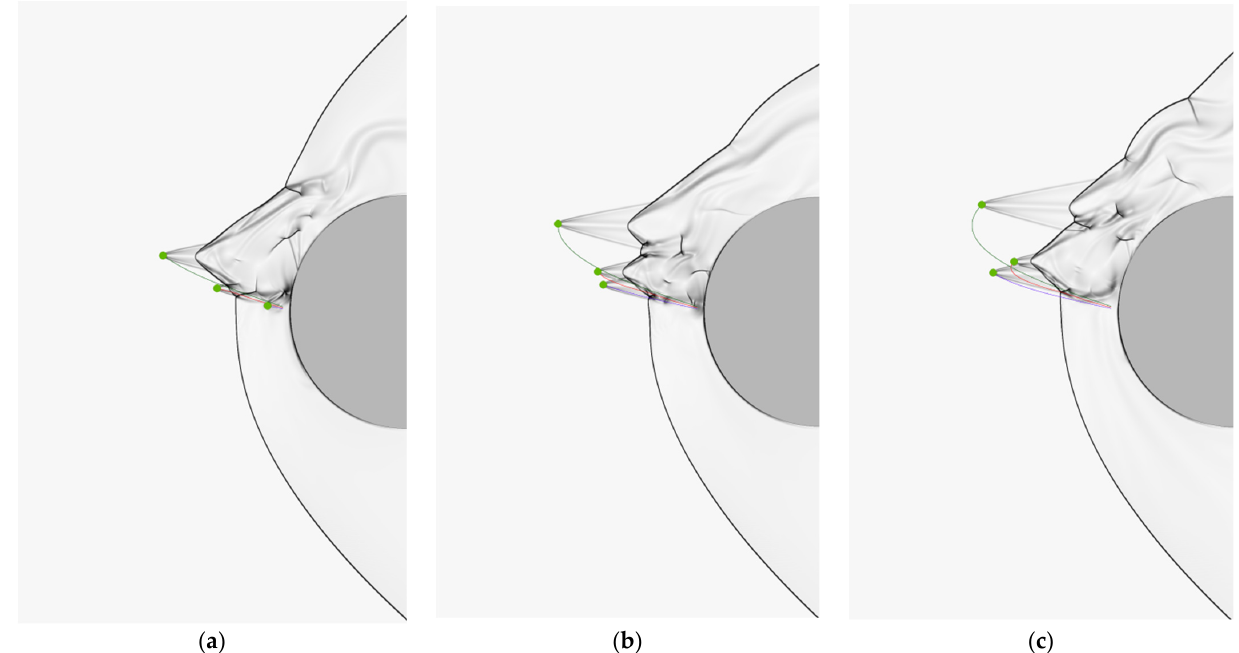
Figure 9. Schlieren images at successive times. ( a ) —0.38 ms, ( b ) —0.63 ms, ( c ) —0.79 ms. A variant with three particles.